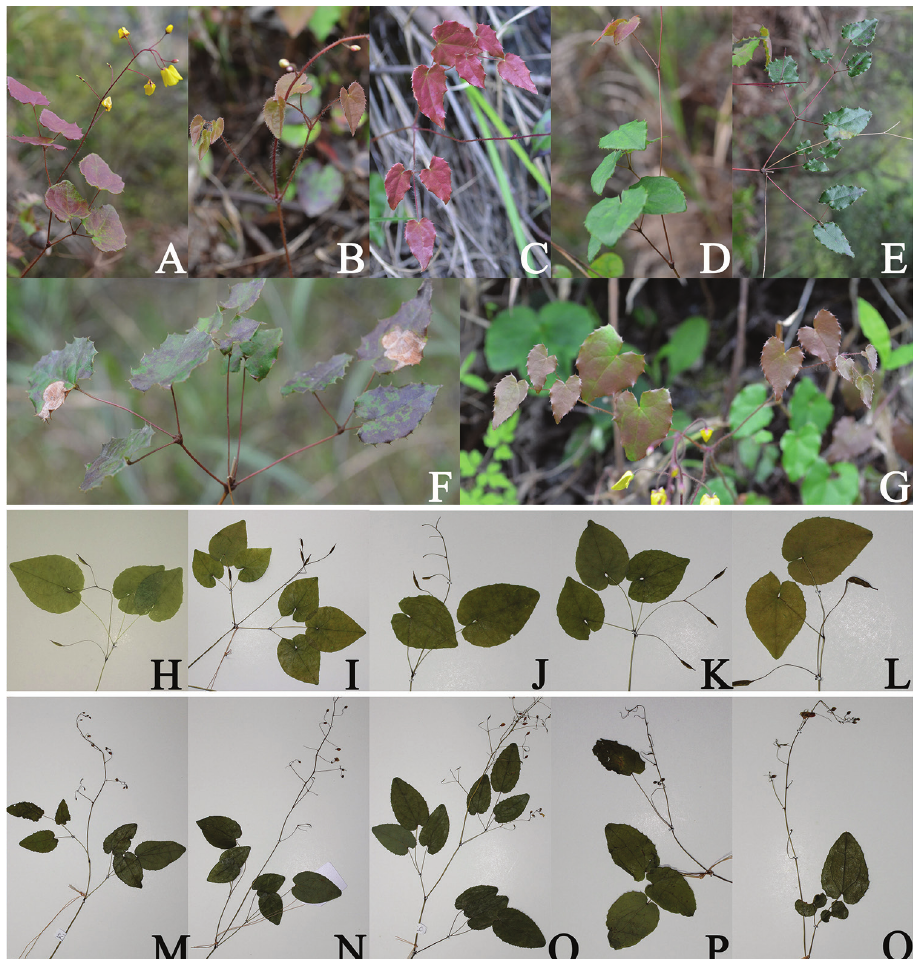
Figure 3. Population variation of leaves morphology in E. ecalcaratum , E. platypetalum , and E. campanu- latum . A–G E. ecalcaratum H–L E. platypetalum M–Q E.